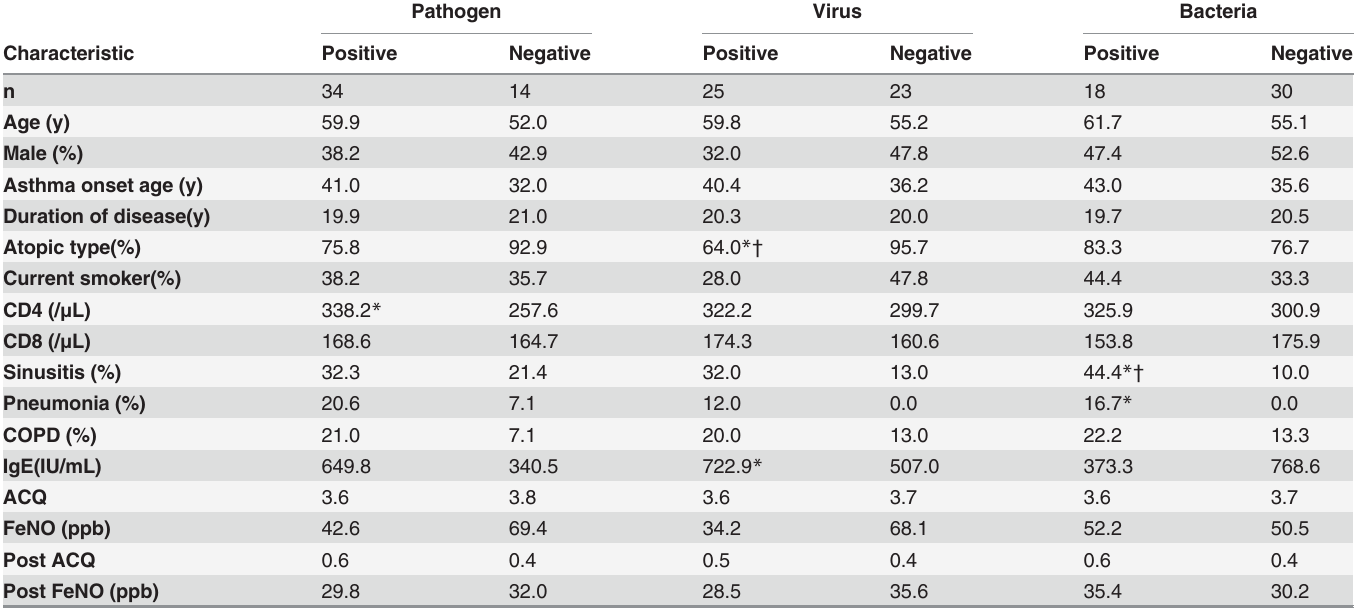
Table 3. Patients ’ characteristics by pathogen detection (n =